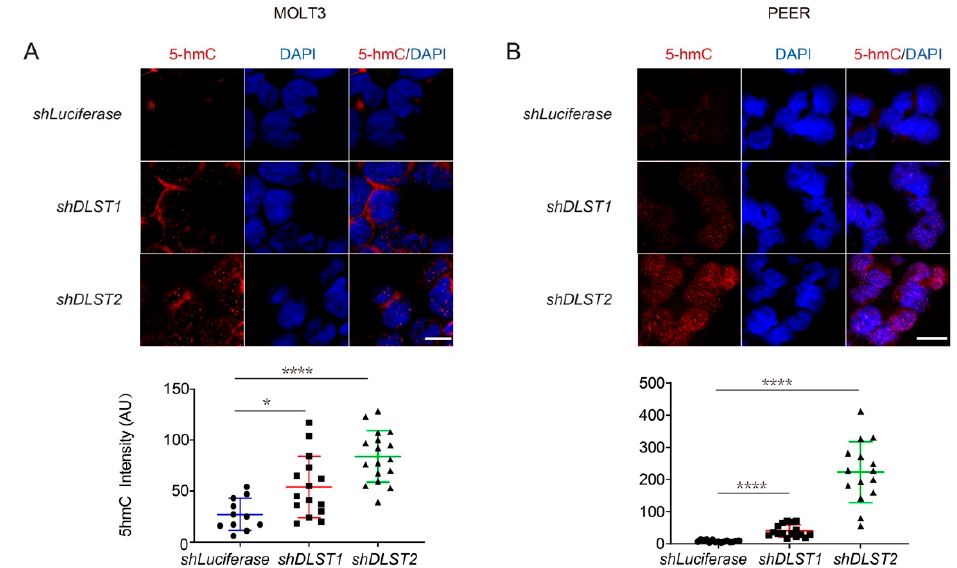
Figure 5. DLST inactivation significantly increases DNA demethylation in human T-ALL cells. ( A , B ) 5hmC staining in MOLT3 ( A ) and PEER ( B ) cells at 5 days after DLST knockdown, with Luciferase knockdown as the control and DAPI (blue) counterstain to demonstrate the intranuclear location of 5hmC staining (red). The quantification of relative 5hmC fluorescence intensity is presented as the mean ± s.e.m., and statistical differences are calculated using an unpaired two-tailed t -test. Scale bar = 10 µ m. * p < 0.05, **** p < 0.0001.